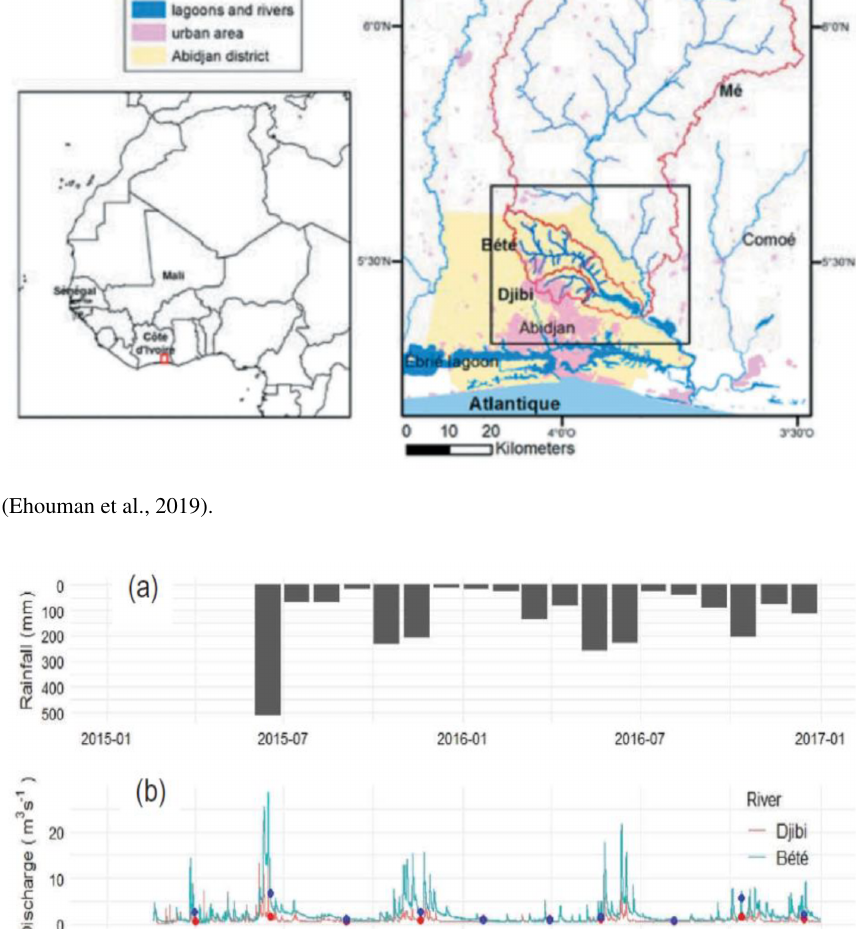
tributaries (Bété and Djibi) feed this lagoon. Among them, Djibi’s watershed is highly urbanized (Fig.